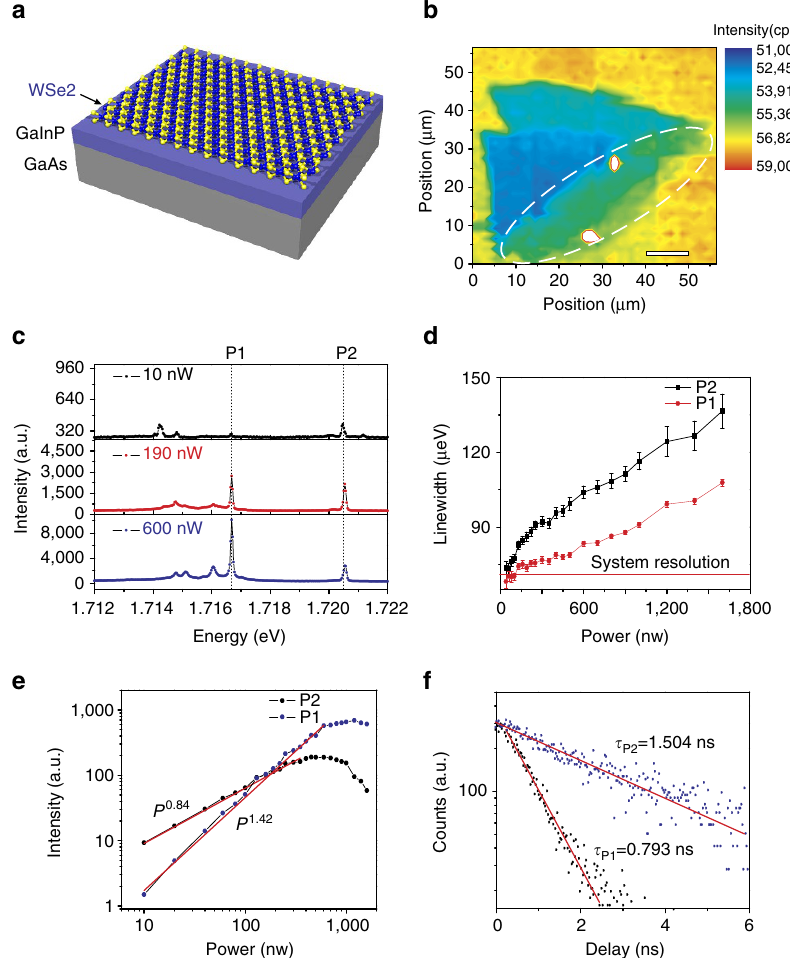
Figure 1 | Narrow spectral lines in monolayer WSe 2 . ( a ) Schematic illustration of the device with the deposited WSe 2 monolayer. ( b ) Contour plot of photoluminescence intensity within the energy range between 1.525 and 1.734eV, over 56 (cid:2) 56 m m. The dashed white line marks the potential monolayer area. ( c ) Photoluminescence spectrum of the localized emitter in the WSe 2 monolayer at 4.5K, showing different emission behaviours with increasing laser power dominated by peaks at 1.7167eV (P1) and 1.7206eV (P2). ( d ) Extracted linewidth of P1 and P2, plotted as a function of excitation power. The spectrum for low excitation power shows resolution-limited linewidth for both P1 and P2. ( e ) The integrated counts of the photon emission from P1 and P2 shows super-linear and sub-linear behaviour with increasing laser power in Log–Log plot. The red line is the power law fitting I p P x , with the extracted x ¼ 0.84 for P2 and x ¼ 1.42 for P1. ( f ) Time-resolved photoluminescence of P1 and P2 show the single exponential decay with the time constant of 0.793 ± 0.017ns for P1 and 1.504 ± 0.028ns for P2. Uncertainties are 1 s.d. values based on a least square fit to the